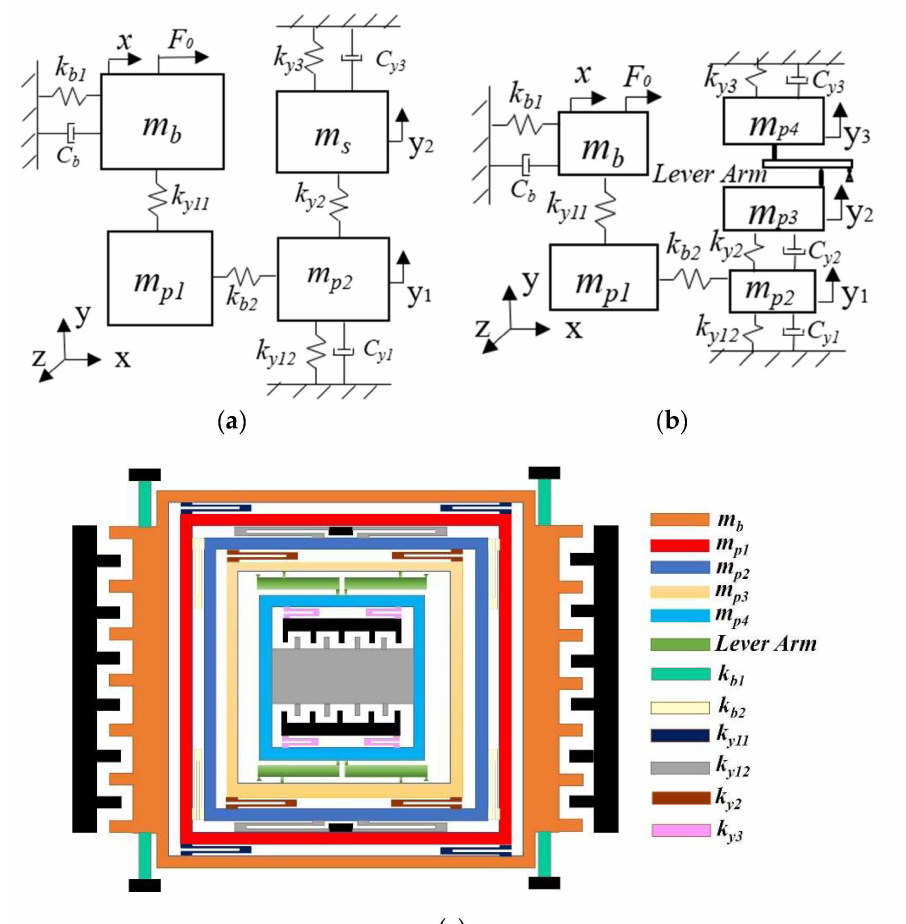
Figure 2. The 3-DOF micro-gyro with ALM: ( a ) sense system of micro-gyro without an ALM; ( b ) sense system of micro-gyro with an ALM; ( c ) physical schematic diagram of